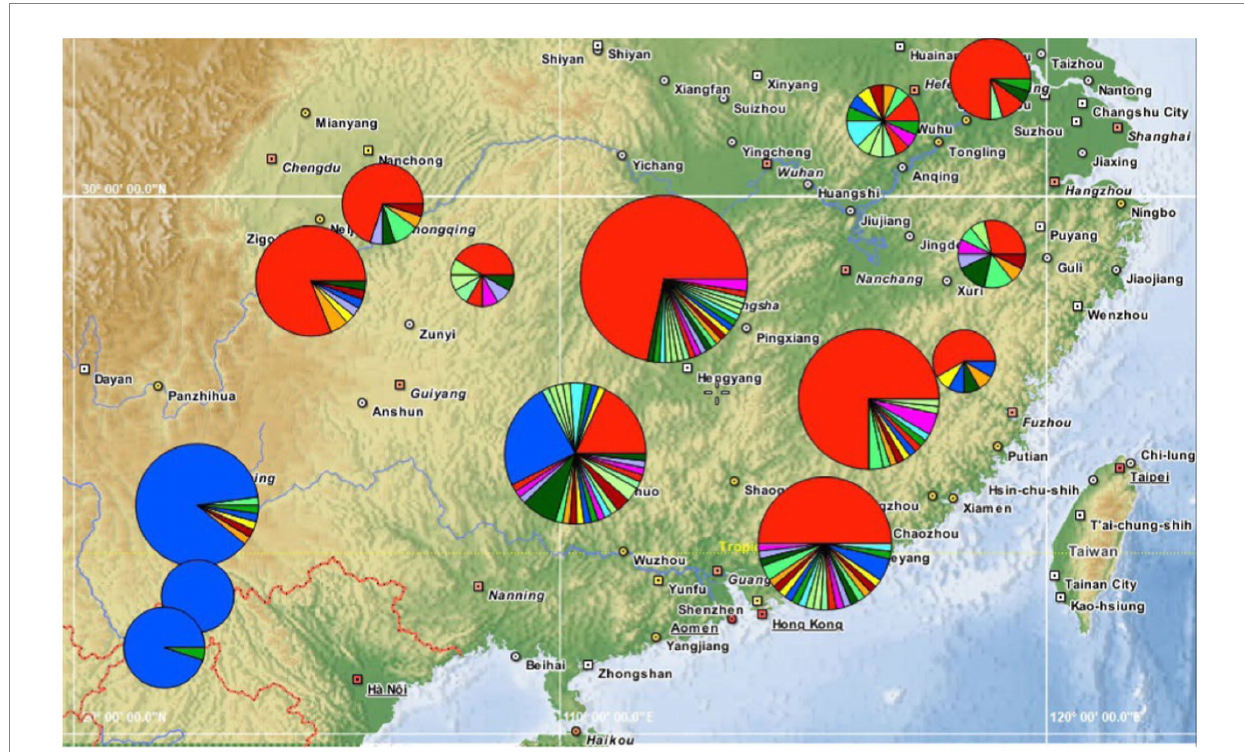
FIGURE 6 Phylogeography of the bamboo grasshopper. Pie charts show relative frequencies of COI haplotypes at each locality, and the colors are consistent with Figure